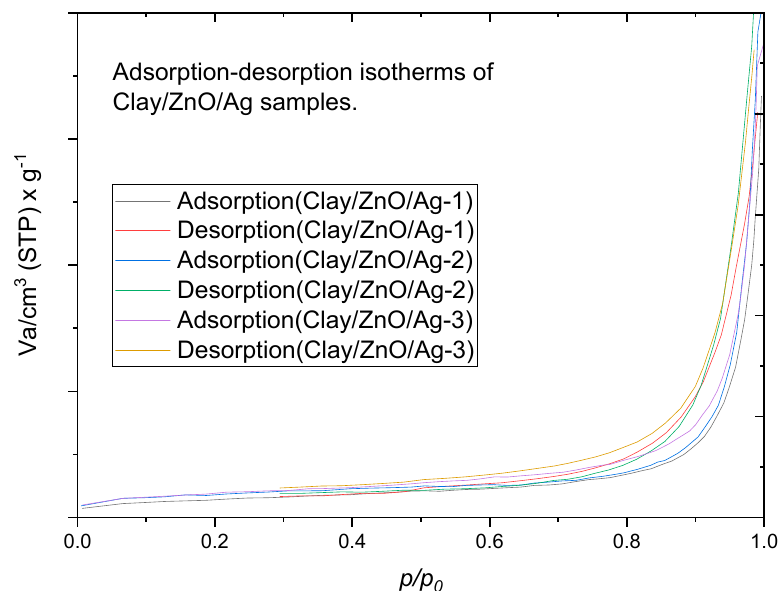
Figure 17. Adsorption-desorption isotherms of nitrogen gas at 77 K of “as-received” pellets of clay/ZnO/Ag samples.